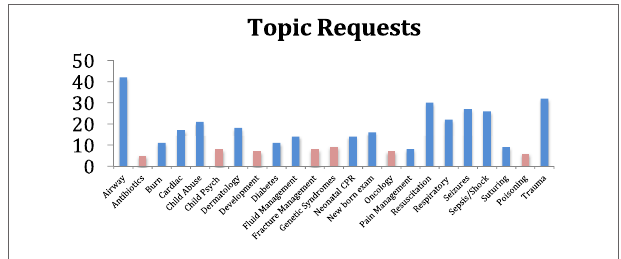
Figure 2 | the topics with the most requests (highlighted in blue) were incorporated into the curriculum